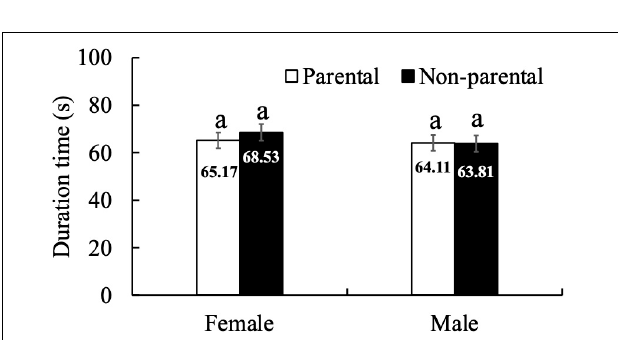
FIGURE 4 | Duration times of egg cannibalism in A. custos adults upon incubation with parental and non-parental eggs. Lowercase letters indicate significant differences ( p < 0.05). Thirty replicates were used for each experimental